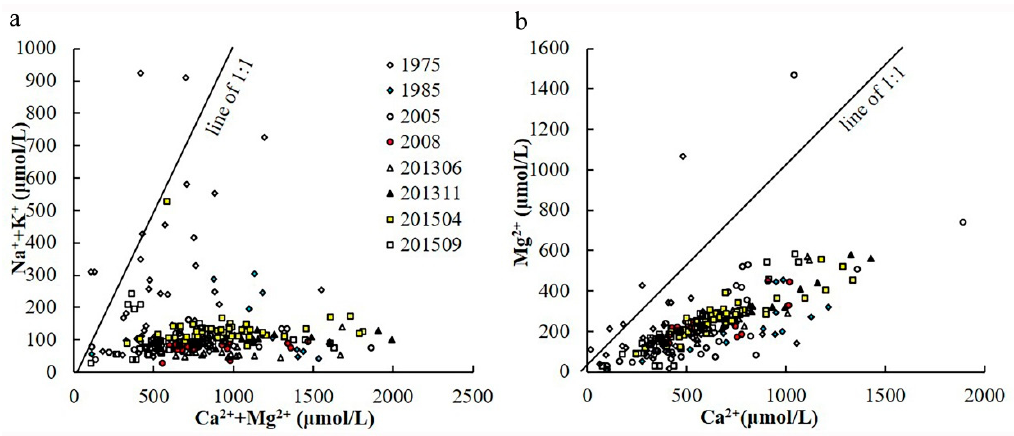
Figure 7. Scatter diagrams showing the relationship of ( a ) Ca 2 + + Mg 2 + vs. Na + + K + and ( b ) Ca 2 + vs. Mg 2 + after correction for atmospheric input, evaporites, and sources of non-silicate Na + input for all sampling periods ( µ mol /